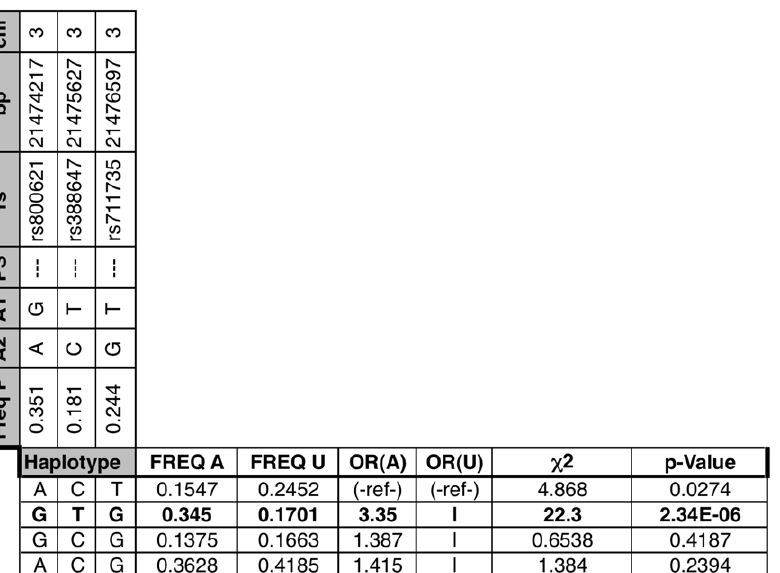
Figure 6. Haplotype Analysis for ZNF385D. ‘‘|’’ indicates haplotype grouped with one above it. Numbers in parenthesis represent 95% confidence interval. OR (A) and OR (U) abbreviate Odds Ratio Affected and Unaffected, respectively. Freq A, U, and P observed haplotype frequency Affected, Unaffected, and Population (control and experimental, this study); PS=Peptide Shift (in this case a conservative instance), italics bases within haplotype signify presence of peptide-shifting